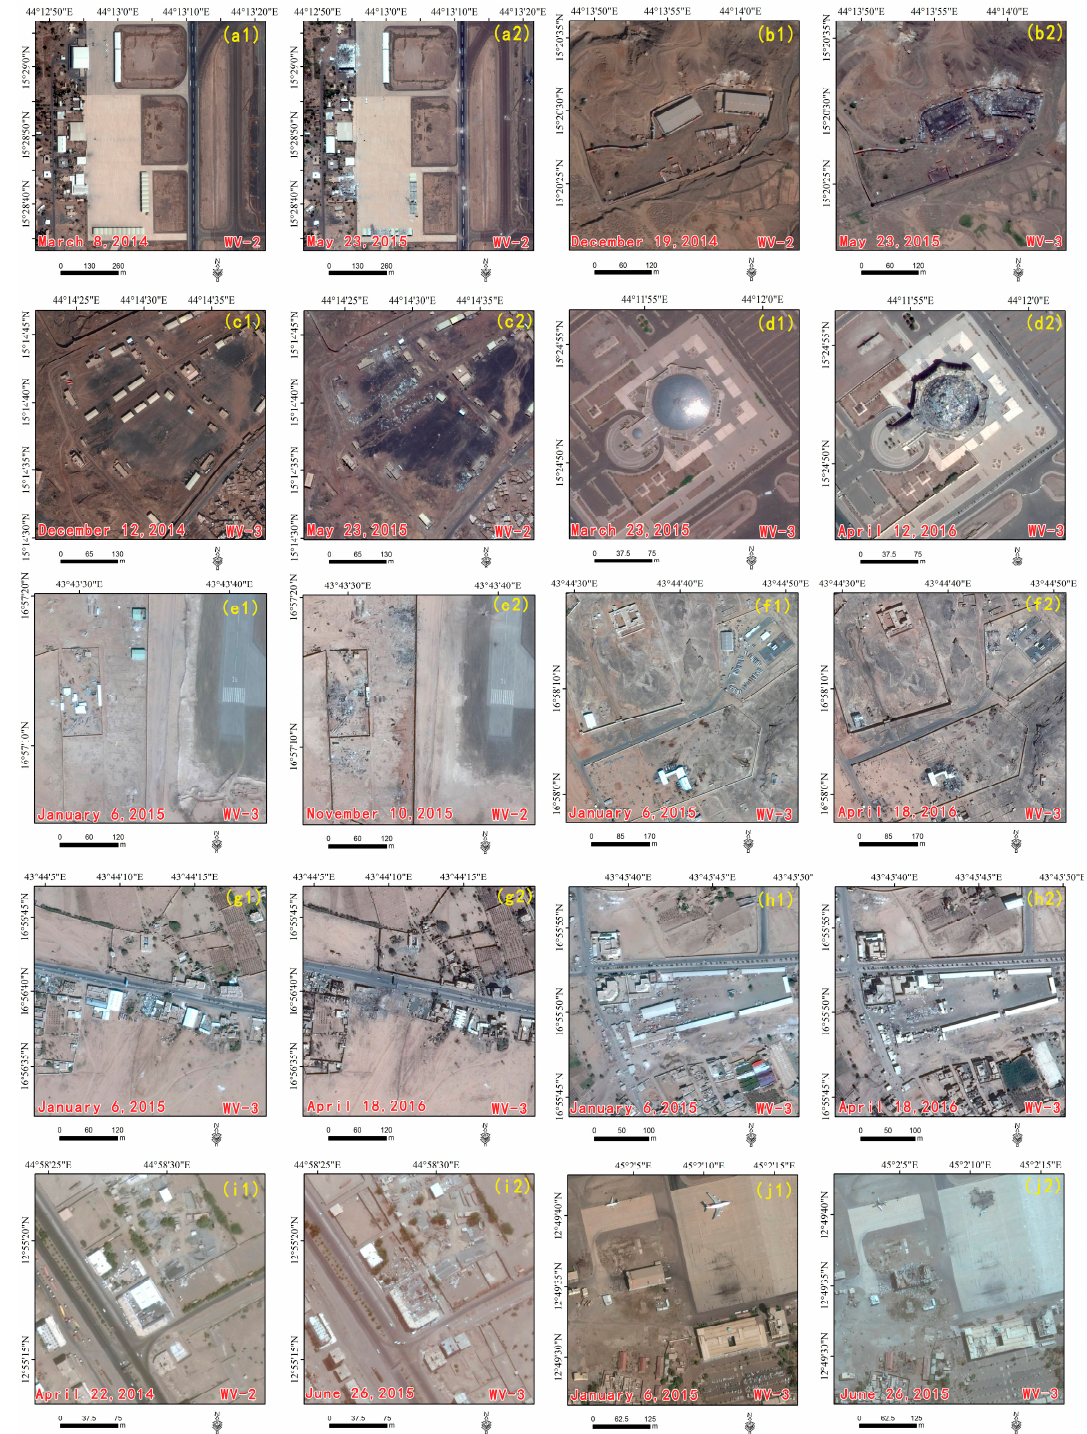
Figure 13. Validation of the infrastructure destruction in Sana’a, Sa’dah and ’Adan: ( a1 , a2 , b1 , b2 , c1 , c2 , d1 , d2 ) represent infrastructure destruction before and after war in Sana’a; ( e1 , e2 , f1 , f2 , g1 , g2 , h1 , h2 ) represent infrastructure destruction before and after war in Sa’dah; and ( i1 , i2 , j1 , j2 ) represent infrastructure destruction before and after war in ’Adan.